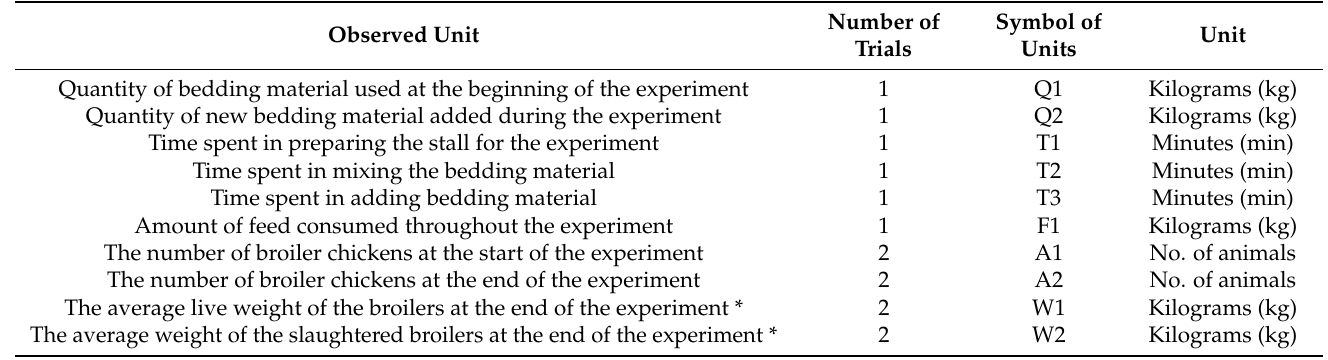
Table 4. Observed units through trial 1 and trial 2.